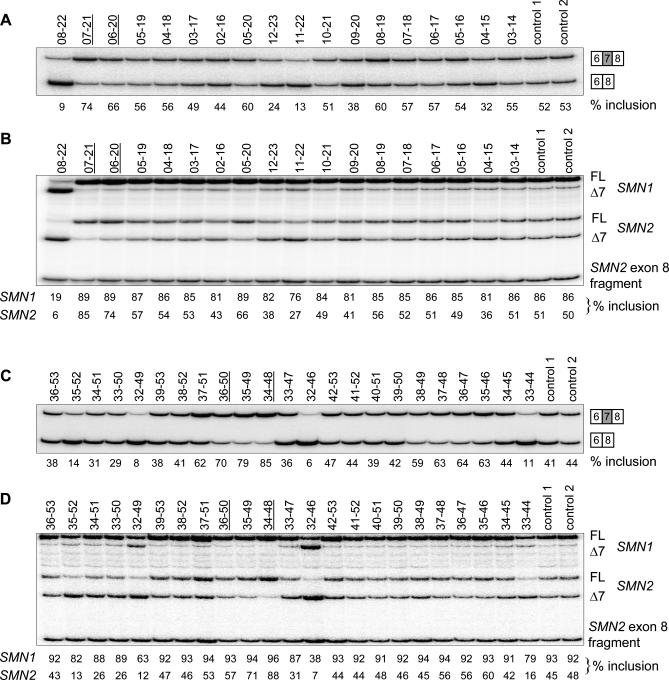
In Vivo Validation of the Two ASO MicrowalksThe effects of the 17 microwalk A ASOs were examined with the SMN2 minigene expressed in HEK293 cells (A) or with the endogenous SMN2 gene in HEK293 cells (B). The effects of the 22 microwalk B ASOs were examined with the SMN2 minigene expressed in HEK293 cells (C) or with the endogenous SMN2 gene in HEK293 cells (D). The in vivo splicing assays were carried out as in Figure 2. Control 1: unrelated oligonucleotide 00–00; control 2: buffer. The percentage of exon 7 inclusion in each lane is indicated below each autoradiogram.